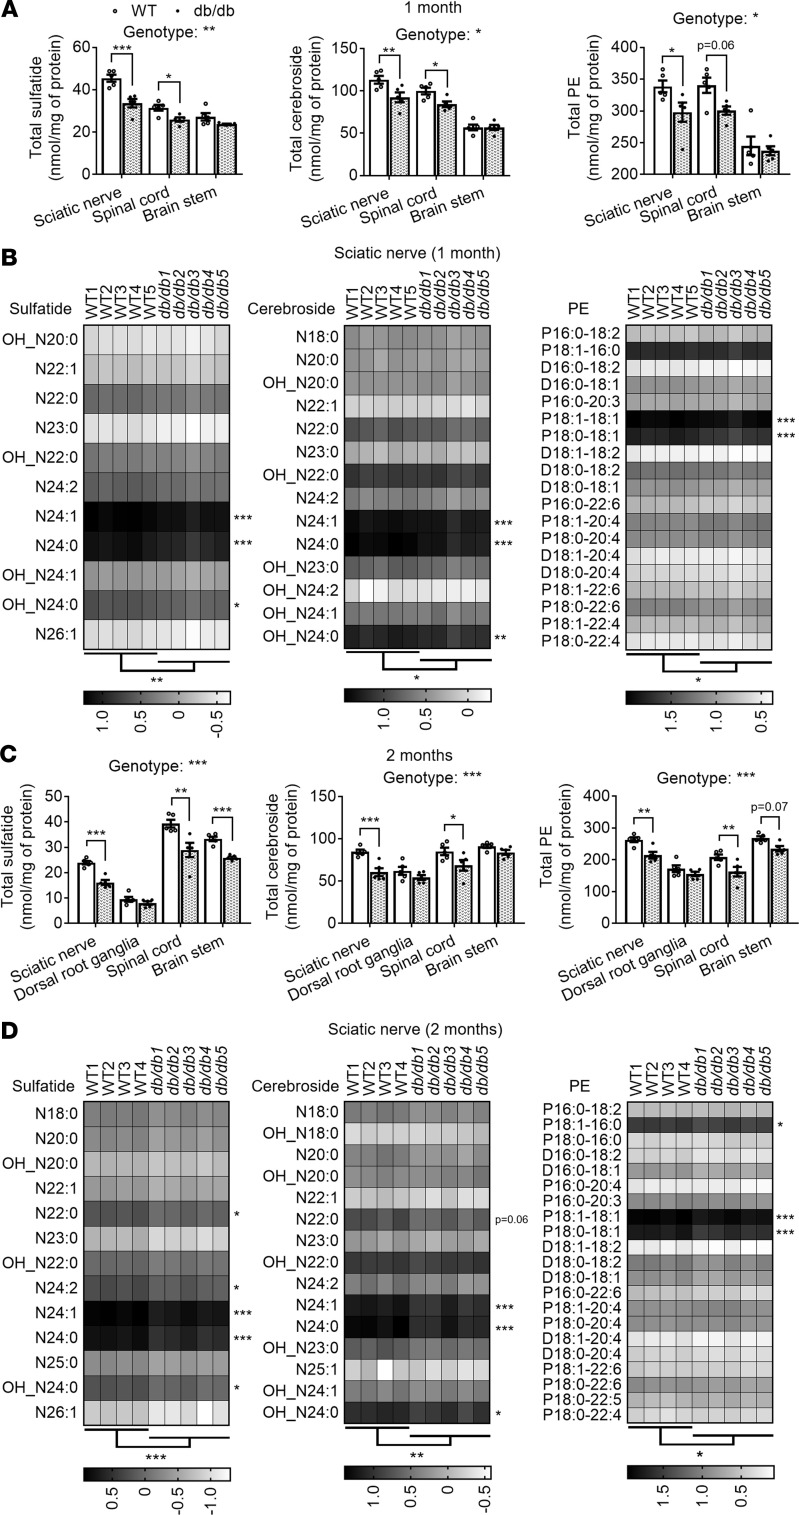
Dying-back depletion of myelin-enriched lipids in obese diabetic mice.Sciatic nerve, dorsal root ganglia, spinal cord, and brainstem tissue from WT and db/db male mice were dissected, flash-frozen, homogenized, and lipid extracted. Sulfatide, cerebroside, and phosphatidylethanolamine (PE) levels were assessed by multidimensional mass spectrometry–based shotgun lipidomics for 1- (A and B) and 2-month-old (C and D) mice. Total levels of each lipid class are displayed as dot plots (WT: open circles/bars; db/db: filled circles/bars); data represent the mean ± SEM of n = 4–5 mice/genotype (A and C). Total levels of each lipid class were compared between genotypes for every tissue examined at each time point using 2-way ANOVA (genotype effect P values specified on top of each graph) and Holm-Šidák multiple-comparisons tests (adjusted P values specified on top of brackets). Molecular species masses expressed as nmol/mg of protein were log transformed and displayed as gray scale heatmaps (B and D). Low-abundance lipid species that made ≤1% of the total class content are not shown and were not included in statistical analyses. Although a specific mass peak may represent >1 cardiolipin molecular species, for simplicity heatmaps display only 1 (most common) lipid species for each mass (row). Molecular species within each lipid class were compared using 2-way ANOVA and Holm-Šidák multiple-comparisons tests on GraphPad Prism 7. Statistics displayed below the heatmaps comparing genotypes and next to the molecular species are based on nontransformed data. N, amide-linked; P, plasmalogen or alkenyl-acyl-linked; D, diacyl-linked. *P < 0.05, **P < 0.01, ***P < 0.001.